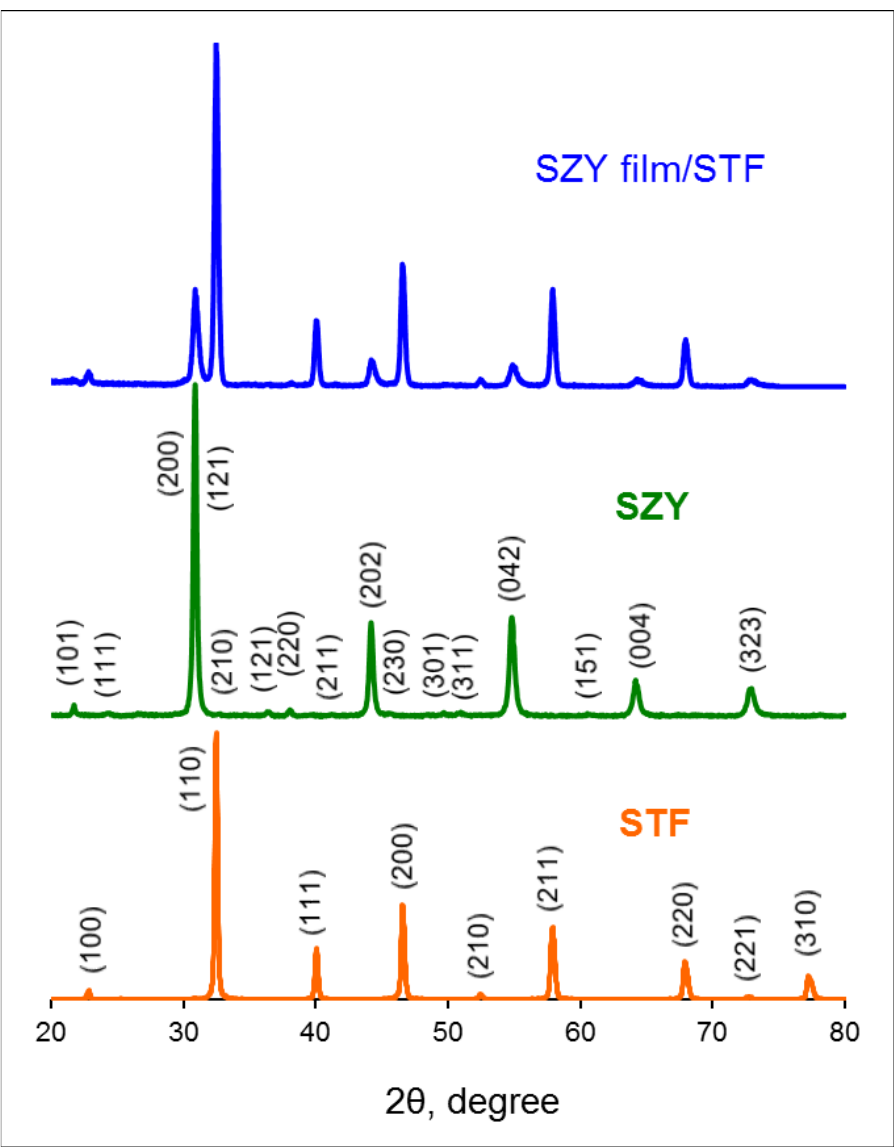
Figure 3. XRD patterns of STF and SZY powders, and SZY film on STF substrate.